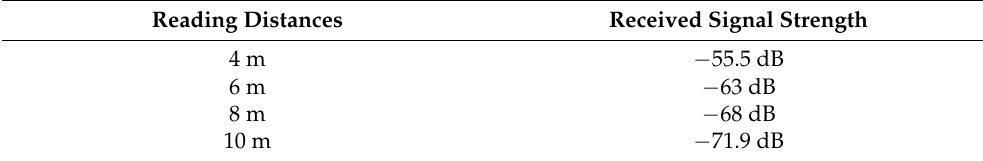
Table 4. Received signal strength by RFID reader.